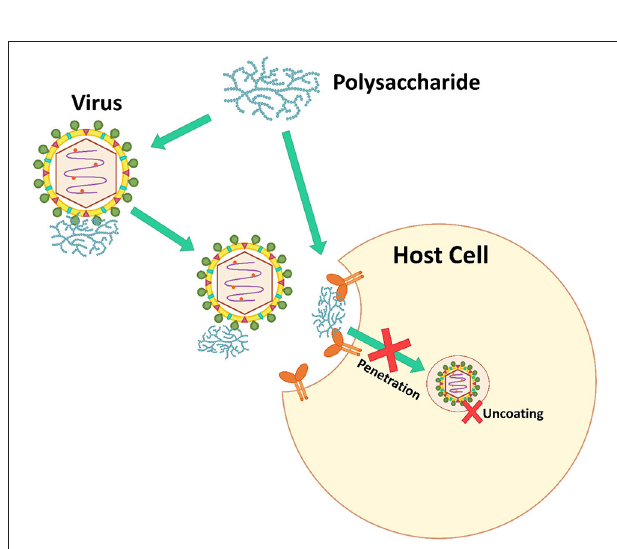
FIGURE 3 | The inhibition mechanism of inhibiting virus adsorption and penetration.